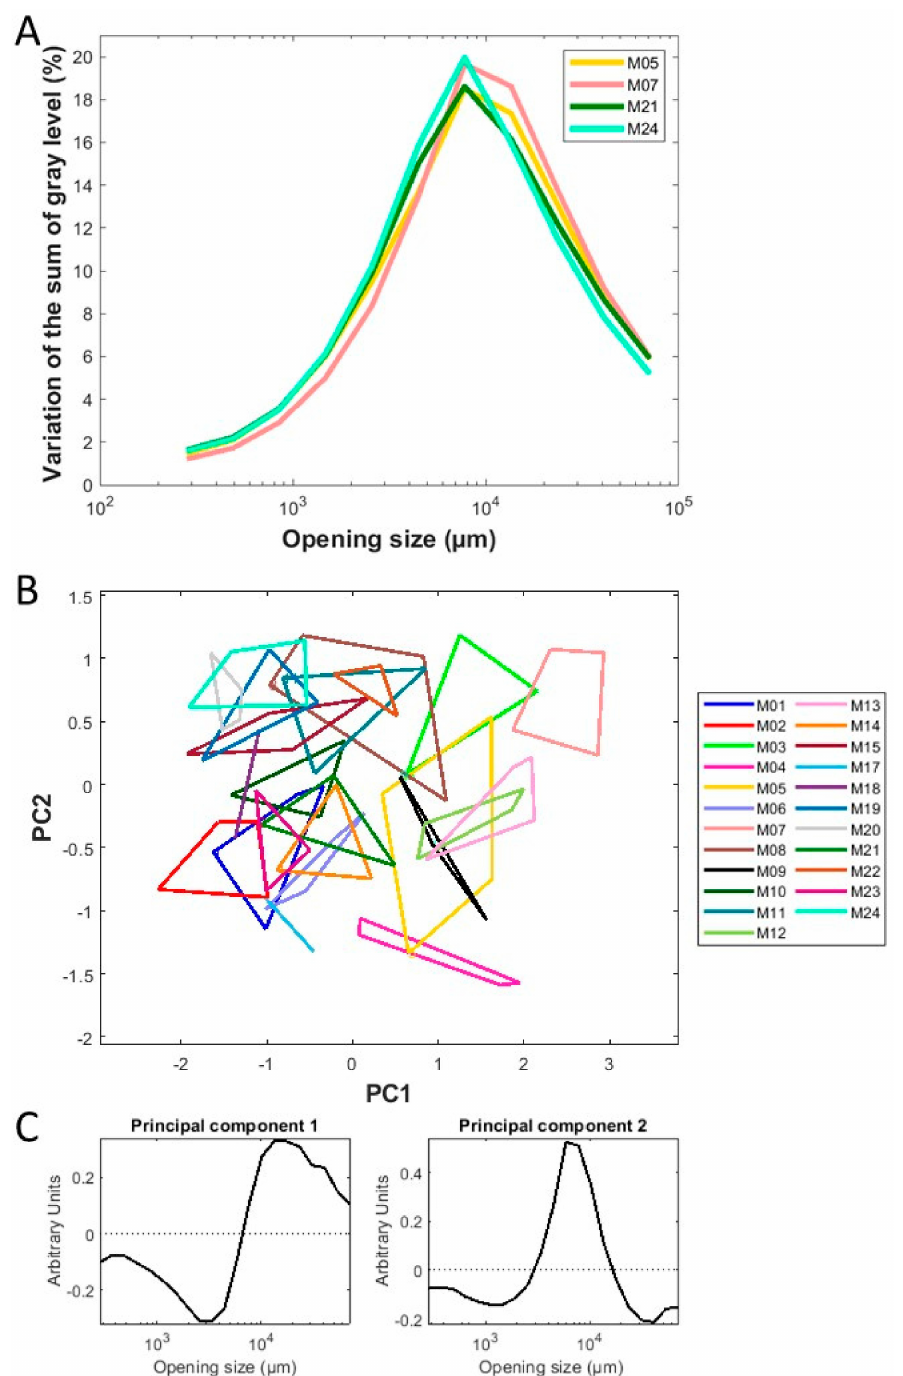
Figure 4. Particle size analysis of the 24 inbred lines of maize (chopped samples). ( A ) Granulometric curves calculated from optical images of four samples. ( B , C ) Principal component analysis based on granulometric curves: similarity map ( B ) and loadings ( C ) of components 1 and 2 (60 and 21% of total variance,